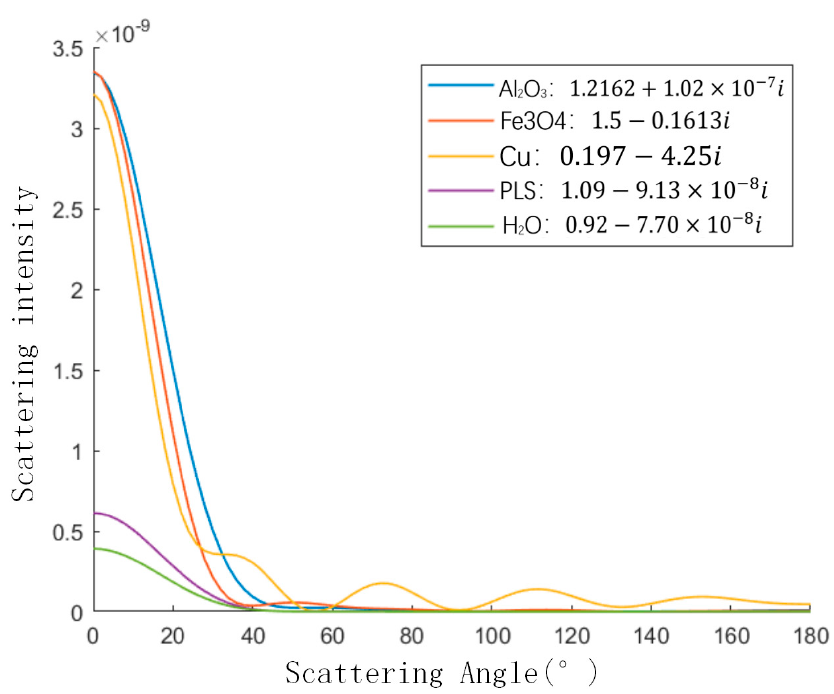
Figure 5. The relationship between scattering angle and scattering light intensity of different particles ( 𝛼 = 5, 𝜑 = 0).